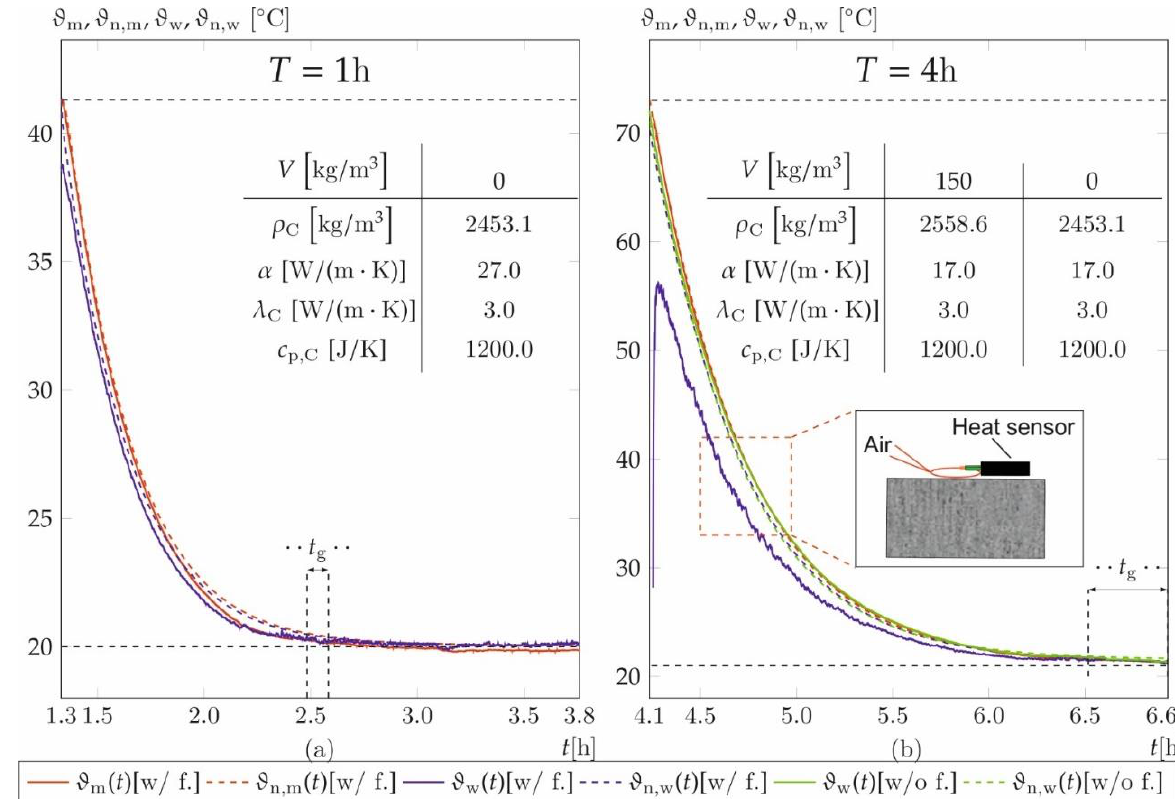
Figure 7. Discretisation of the beams.